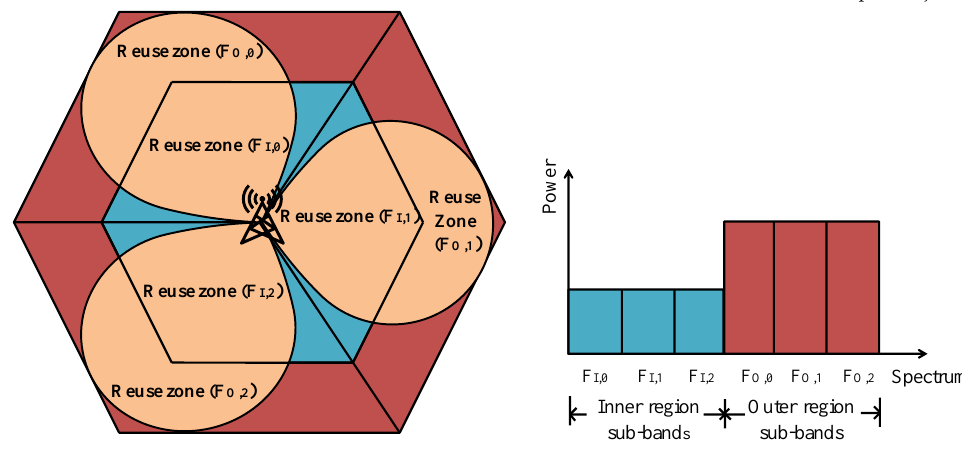
Figure 1. Spectrum partitioned in fractional frequency reuse (FFR) scheme using three 120°-directional antennas.